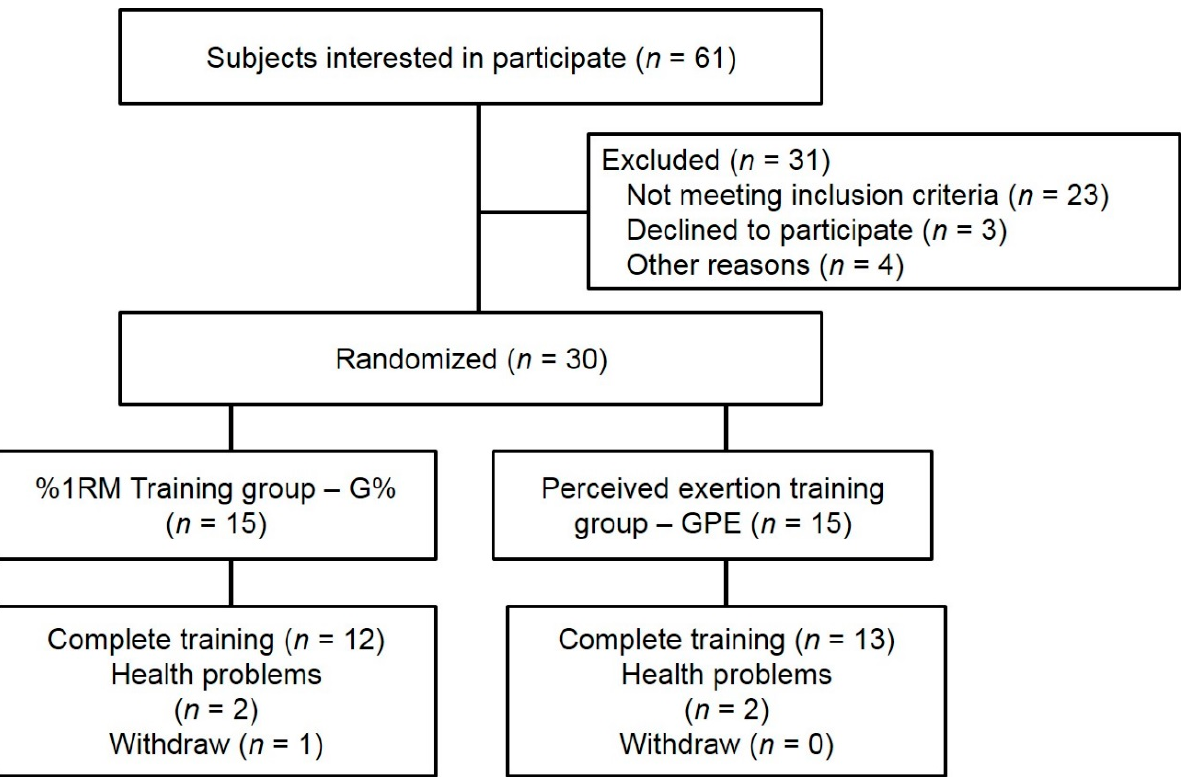
Figure 1. Flowchart with description of subject recruitment and assignment to training groups.